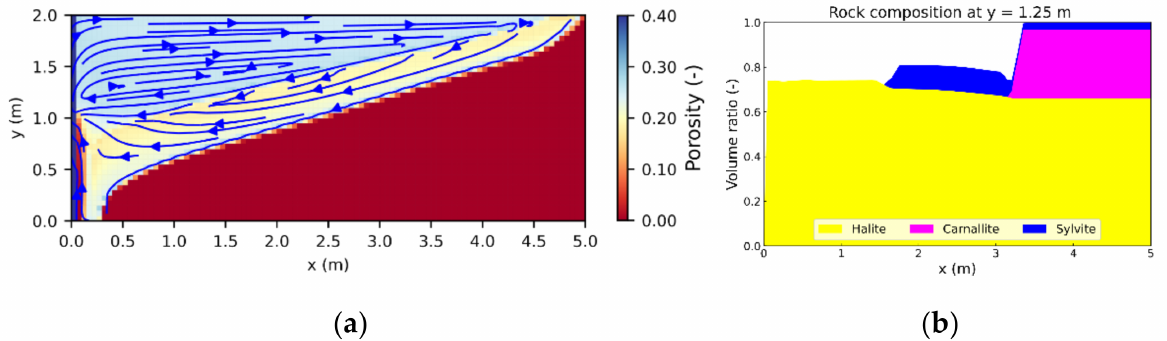
Figure 11. Convection cell of a fully transport-dominated system: ( a ) porosity distribution and ( b ) mineralogical composition after a simulation time of 2 years for a homogeneous potash seam and k max = 5 × 10 − 4